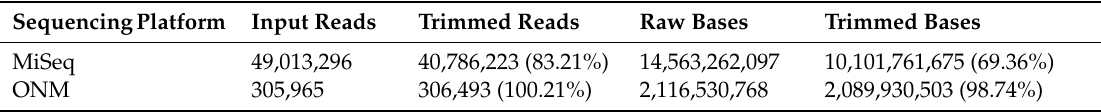
Table 1. Information on next generation sequencing (NGS) data of Pinus densiflora sequenced in this